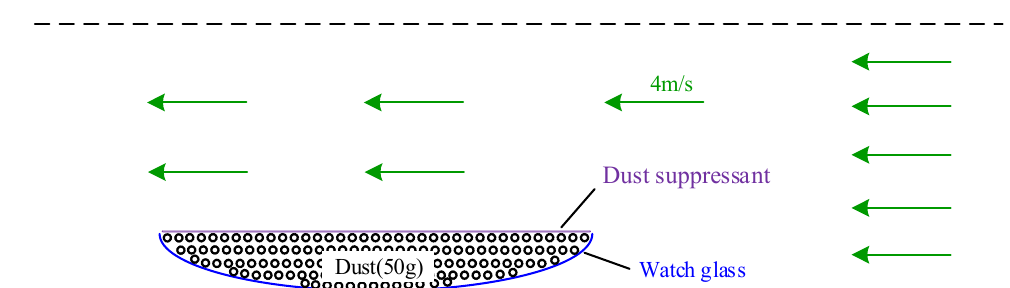
diagram of surface wind erosion rate experiment.